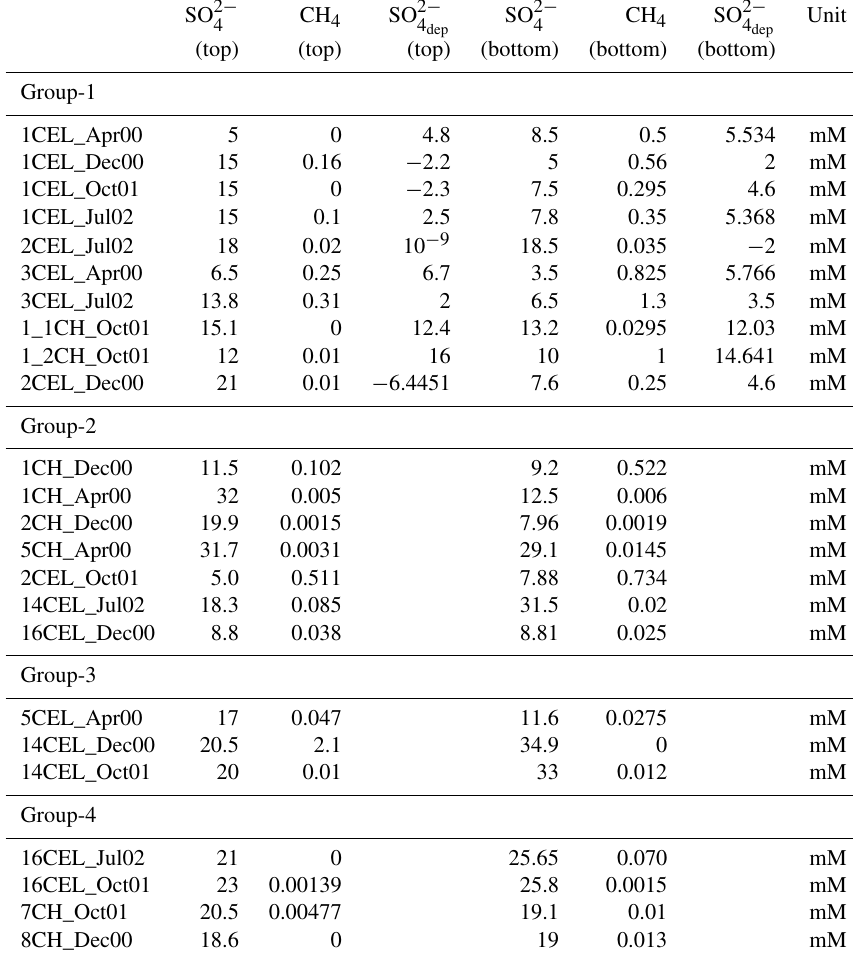
Table A2. Boundary conditions used in the